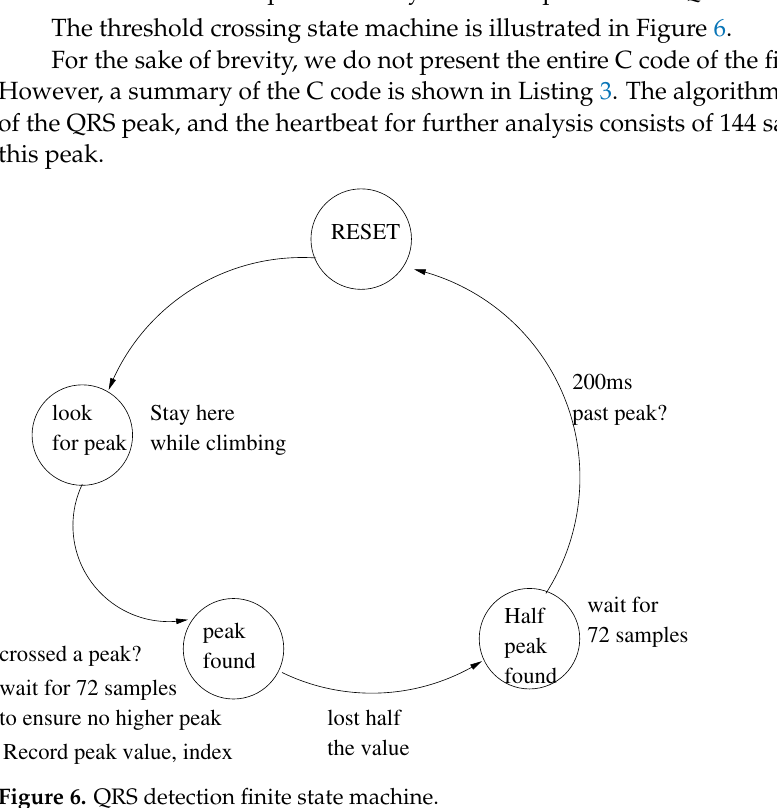
Figure 6. QRS detection finite state machine. Listing 3. QRS peak detection FSM code outline.